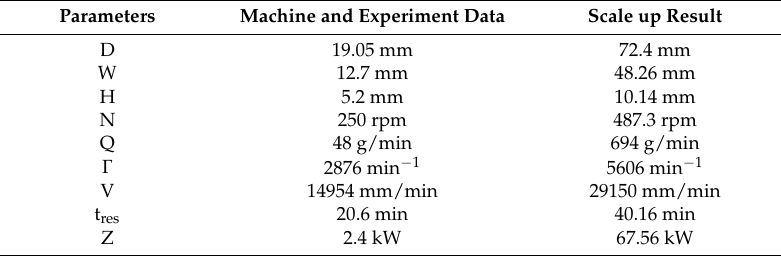
Table 6. Experiment data and scale up